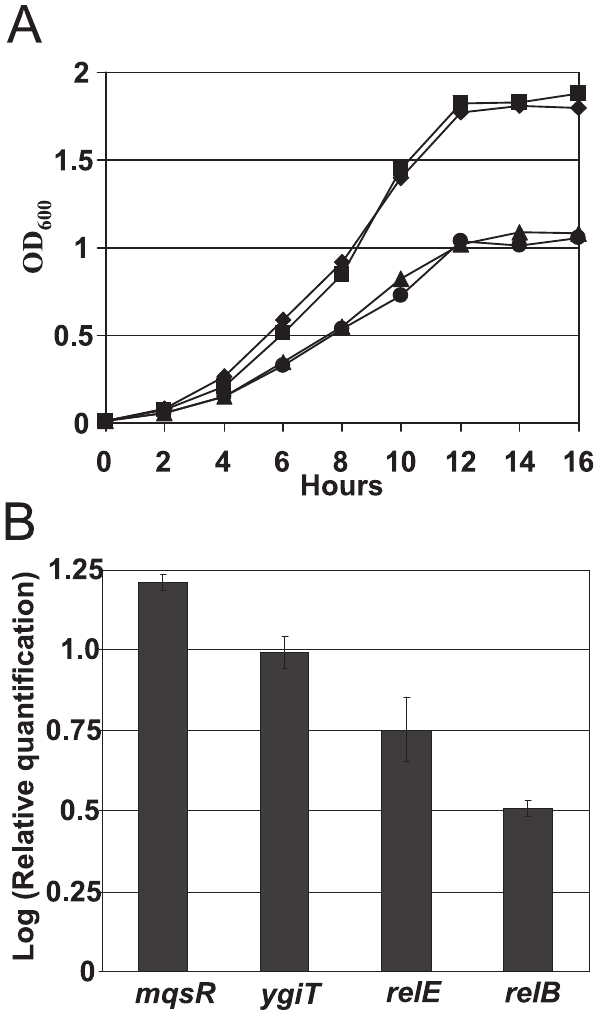
ybjN mutant and strain over-expressing ybjN in LB broth at 37 u C. ¤ : E. N coli strain BW25113 (BW), & : D ybjN mutant , m : E. coli strain BW25113 : E. coli strain BW25113 (pYbjN2). pYbjN1 and pYbjN2: E. coli (pYbjN1), and E. amylovora ybjN gene in pGEM T easy vector, respectively;